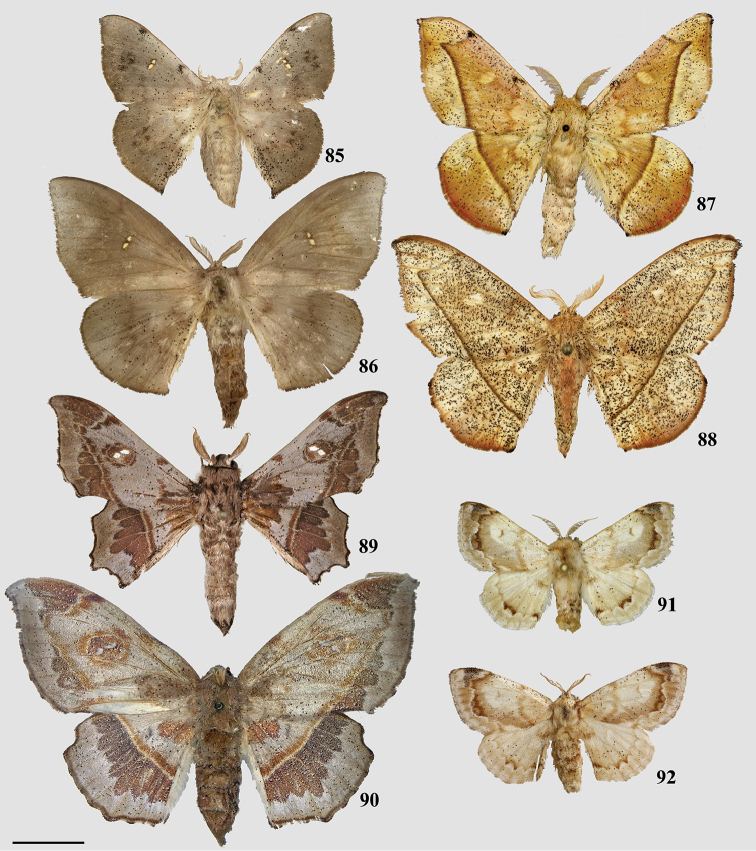
Adult specimens of type species of genera belonging to Mimalloninae. 85Eadmunaesperans, male (MWM) 86E.esperans, female (MWM) 87Macessogacffabia [photo S Naumann] (ISEZ) 88M.cffabia, female (NHMUK) 89Mimalloamilia [photo R Lahousse] (MNHN) 90M.amilia, female [reused with permission St Laurent and Cock (2017), Zootaxa] (MJWC) 91Tostalloalbescens, male [reused with permission from St Laurent and Mielke (2016), ZooKeys] (CGCM) 92Tostalloalbescens, female [reused with permission from St Laurent and Mielke (2016), ZooKeys] (NHMUK). Scale bar: 1 cm.